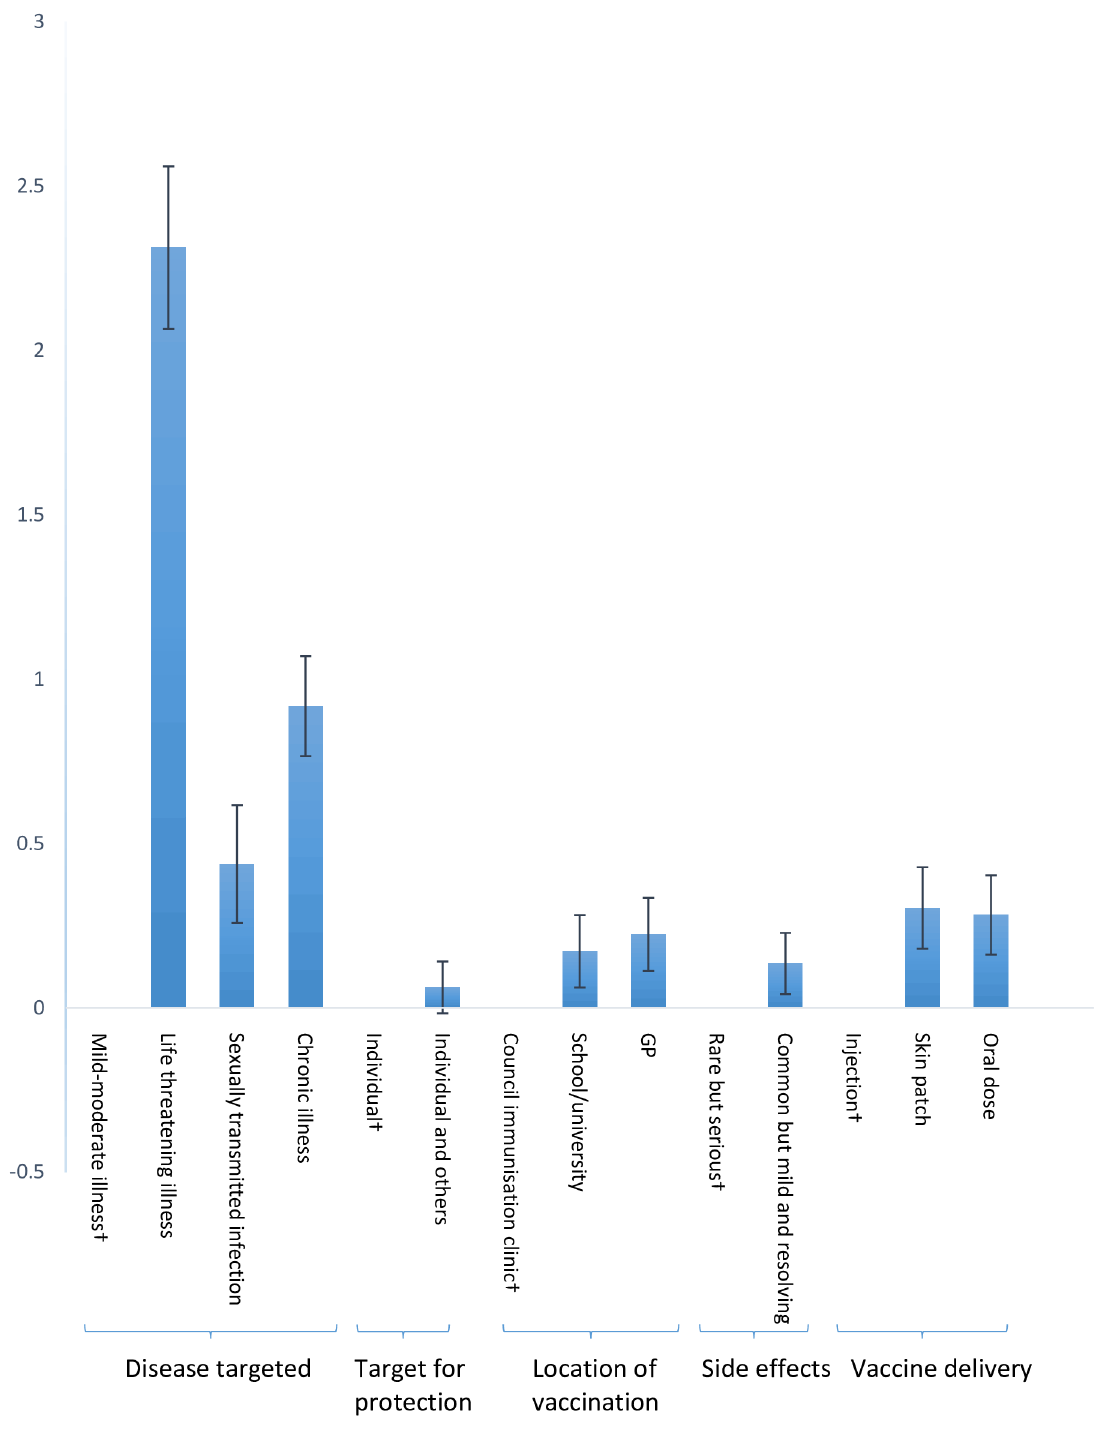
Fig 1. Preferenceweights for nonmonetary attributes. † Reference(omitted) level for each attribute.